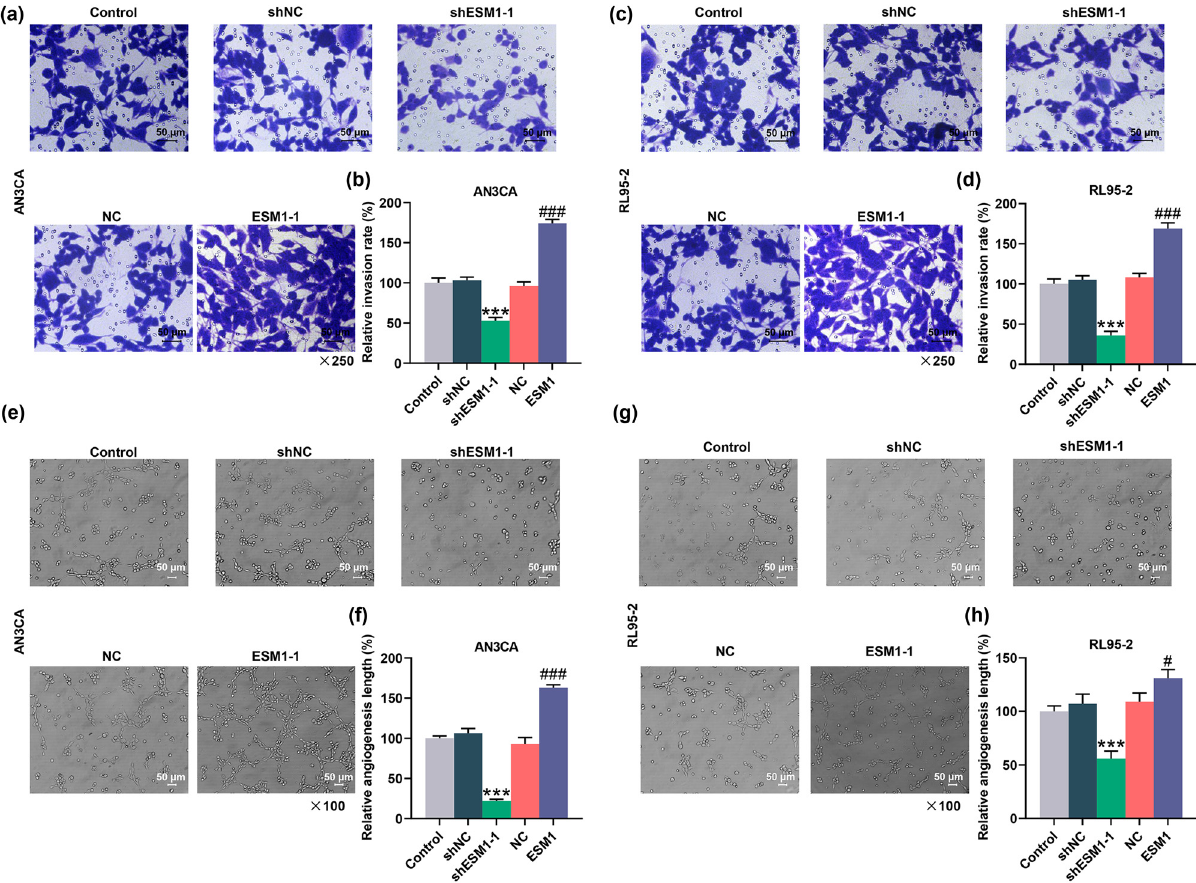
Figure 4: ESM1 overexpression promoted EC cell invasion and angiogenesis, while silencing of ESM1 had opposite e ff ects. ( a – d ) The invasion of AN3CA or RL95 - 2 cells in the control, shNC, short hairpin RNA - targeted ESM1 ( shESM1 - 1 ) , NC, and ESM1 groups was detected by Transwell assay. The representative image was presented ( magni fi cation: × 250 times; scale bar: 50 µm ) and relative invasion rate was quanti fi ed. ( e – h ) Tube formation assay was performed to assess the e ff ect of ESM1 overexpression or silencing on angiogenesis. The representative image was presented ( magni fi cation: × 100 times; scale bar: 50 µm ) and angiogenesis length was measured. *** P < 0.001 vs Sh - NC; # P < 0.05, ### P < 0.001 vs